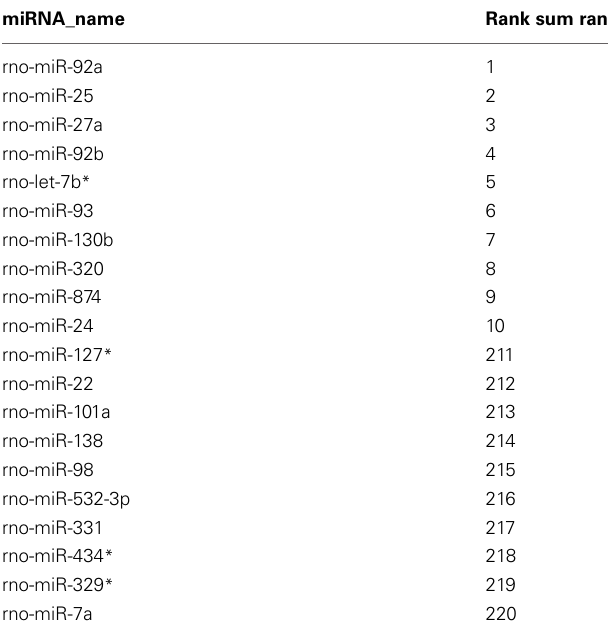
Table 2 | Top 10 high-ranked and top 10 low-ranked miRNAs according to Rank Sum